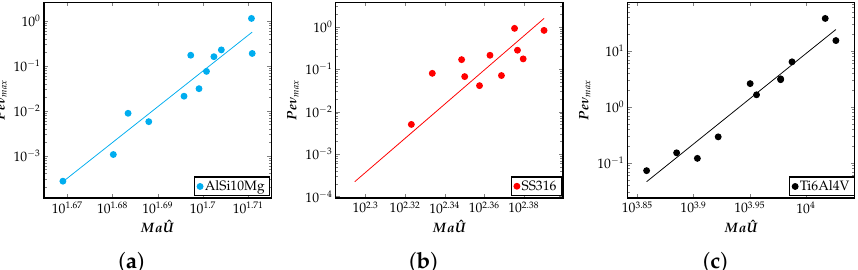
Figure 5. Measure of total advection measured as Pe ν max vs. surface tension based advection Ma ˆ U = a 0 Ma + a 1 MaE + a 2 MaPe on a log–log scale for ( a ) AlSi10Mg, ( b ) SS316, ( c ) Ti6Al4V alloys. Corresponding plots comparing IN718 and AZ91D alloys, and a comparison of all the five alloys considered in this work can be found in Figures S1 and S2 of the Supplementary Information, respectively. The advection measure corresponds to the degree of fluid flow inside the meltpool. Each point in these plots represent a single simulation result for the relevant quantities plotted, and is obtained from the FEM